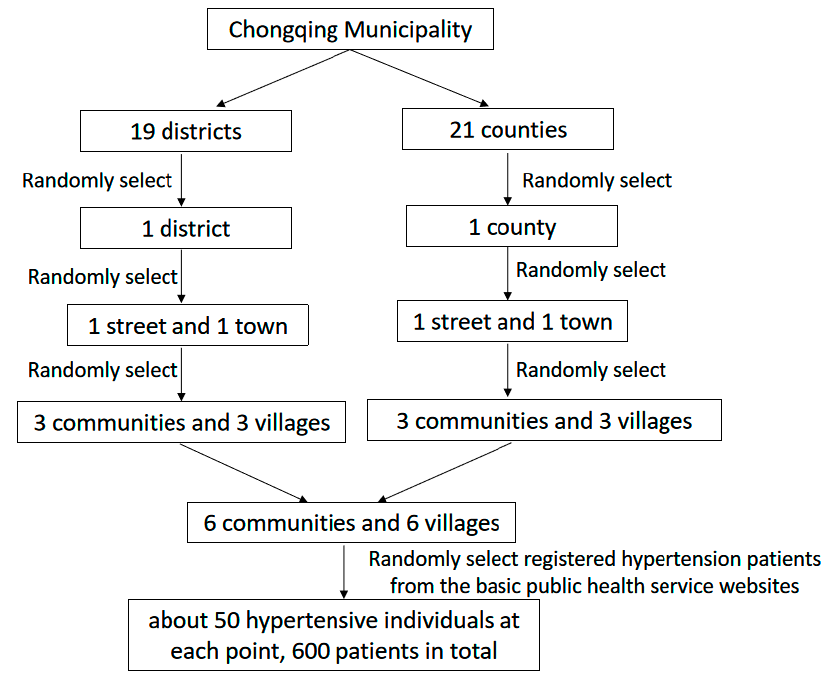
Figure 1. Stratified sampling.